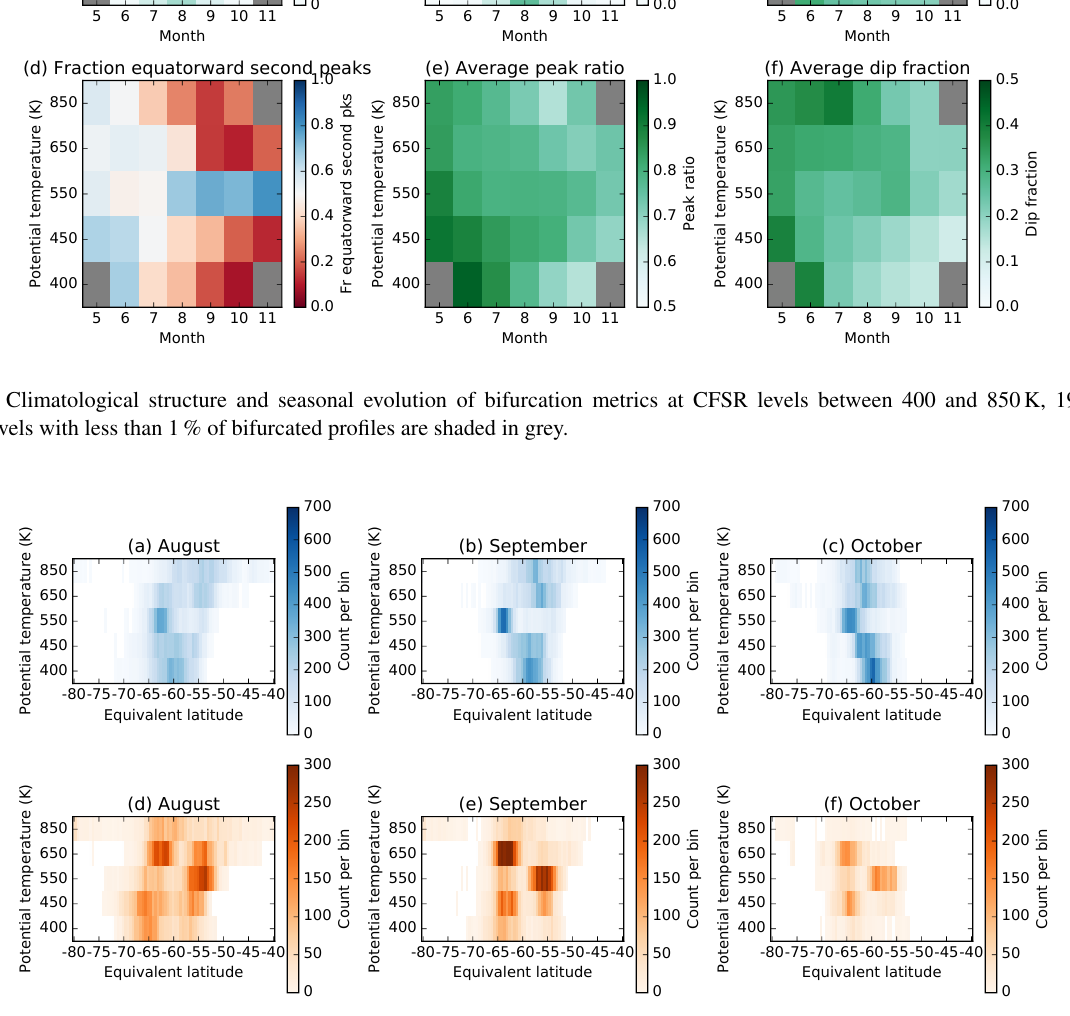
peaks are more tightly clustered around − 60 ◦ and secondary peaks tend to be to poleward of primary